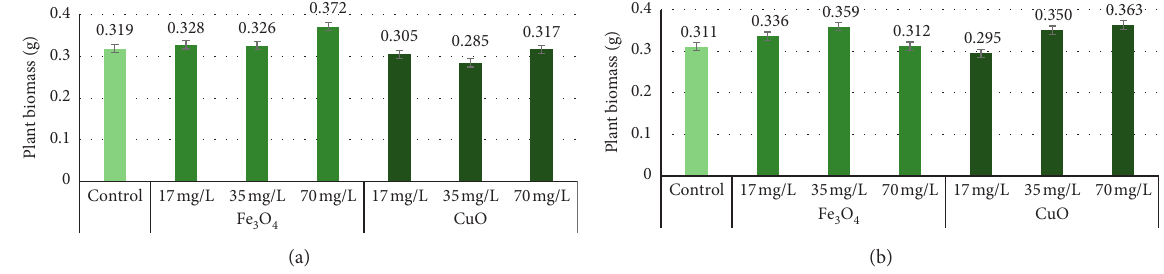
Figure 3: The “Marthe” and “KWS Olof” varieties fresh plant biomass with 17mg/L, 35mg/L, and 70mg/L concentrations of Fe CuO NPs. Values are the mean of three replicates with SD. (a) “Marthe” variety fresh plant biomass with different concentrations of Fe 3 O 4 and CuO NPs. (b) “KWS Olof” variety fresh plant biomass with different concentrations of Fe 3 O 4 and CuO NPs.